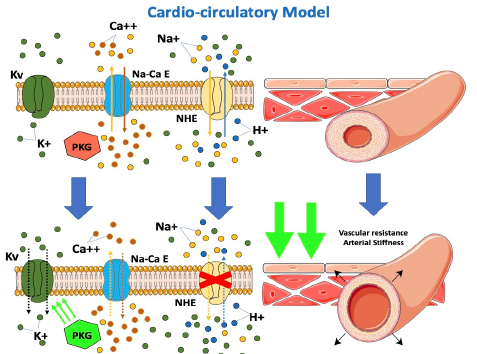
Figure 3. Effects of SGLT2-i on the cardio-circulatory model.